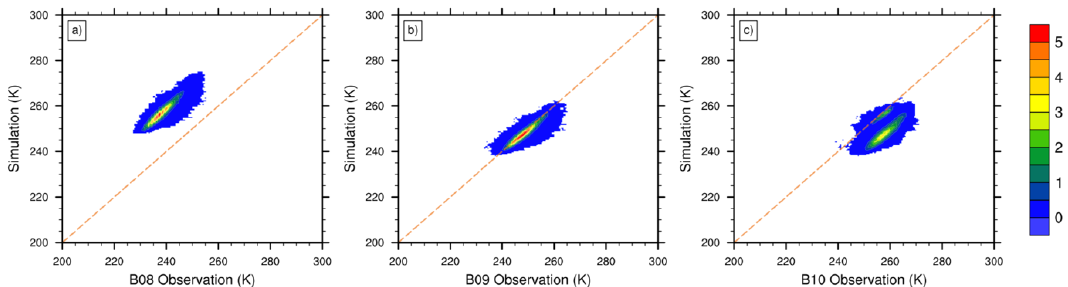
Figure 13. The joint probability distribution (PDF) of the simulated and observed brightness temperatures of (a) Band 8, (b) Band 9 and (c) Band 10 in July 2016; more than seven million pixels are included. Units are